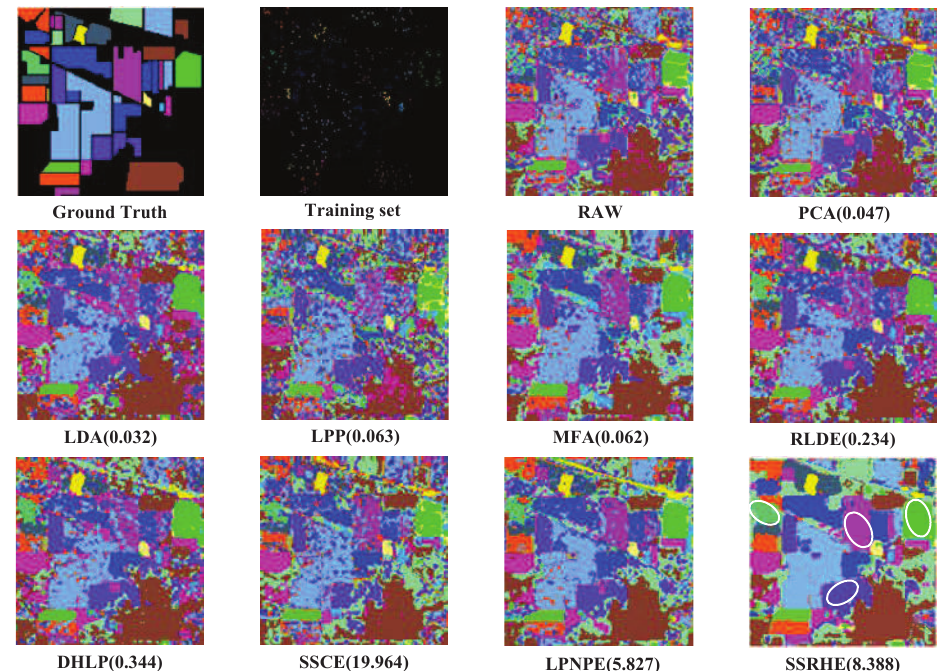
Figure 10. Classification maps of different DR methods with 1-NN on the Indian Pines dataset. Note that the time cost of corresponding DR algorithms is marked in